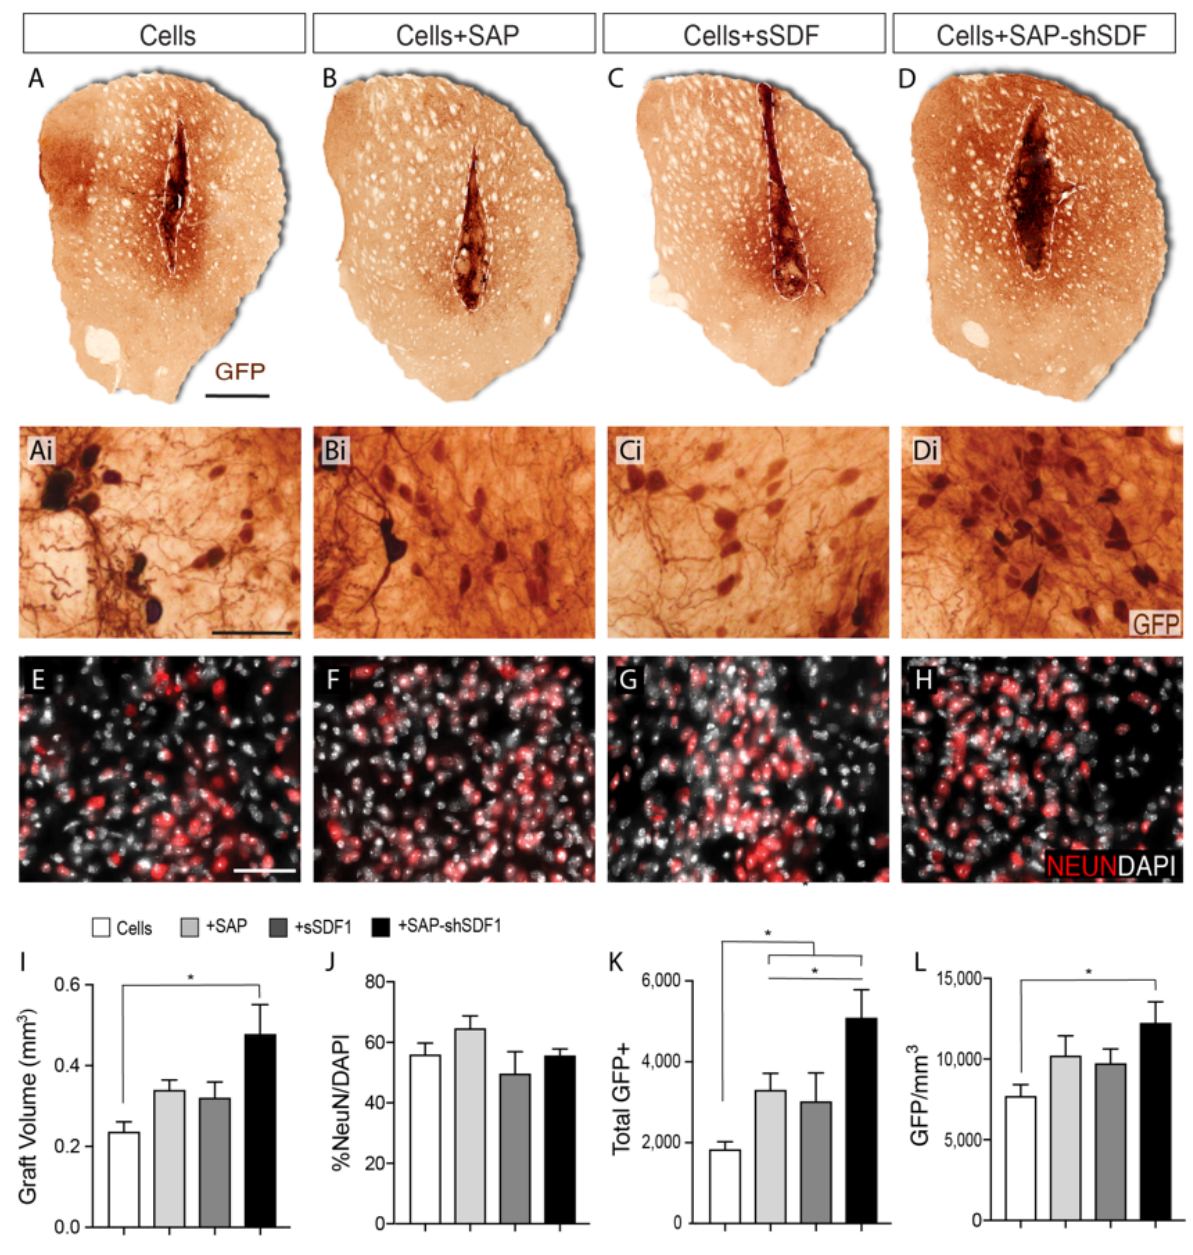
Figure 2. SDF1 functionalised SAP scaffold increase graft size and number of dopamine neurons within foetal tissue neural transplants. ( A – D ) Representative photomicrographs of VM foetal tissue grafts showing GFP staining for DA neurons at 12 weeks. Dashed line delineates the graft core, containing the GFP+ DA cell bodies. ( Ai – Di ) Higher magnification images from ( A – D ) illustrating the density of GFP+ DA neurons and ( E – H ) NeuN+ neurons. ( I ) Graft volumetric assessment by GFP labelling revealed that grafts in the presence of the SDF1-functionalised SAP hydrogel were significantly larger compared to the other graft groups. ( J ) NeuN+ neuronal density was unchanged by SDF and/or SAP treatment. ( K ) Quantification of GFP+ cells revealed laminin-based SAP significantly increased DA neuron number, synergistically enhanced by sustained SDF1 delivery. ( L ) GFP+ DA neuron density was significantly increased by the presence of functionalized SAP scaffolds. Data represent Mean ± SEM, n = 5–7 Grafts/group. * p < 0.05. Scale bar: ( A – D ) 1 mm; ( Ai – Di , ( E – H )) 100 μ m.